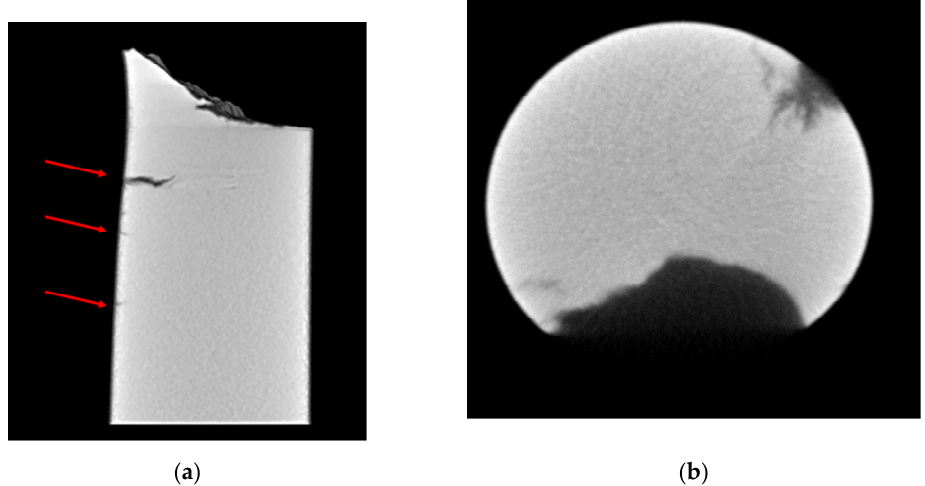
Figure 7. ( a ) µTomo 3D reconstruction of tomographic vertical cut of specimen in H 2 . The red arrows point to the cracks propagating from the outer surface; ( b ) µTomo 3D reconstruction of tomographic cut of specimen in H 2 showing the internal structure of the cracks.